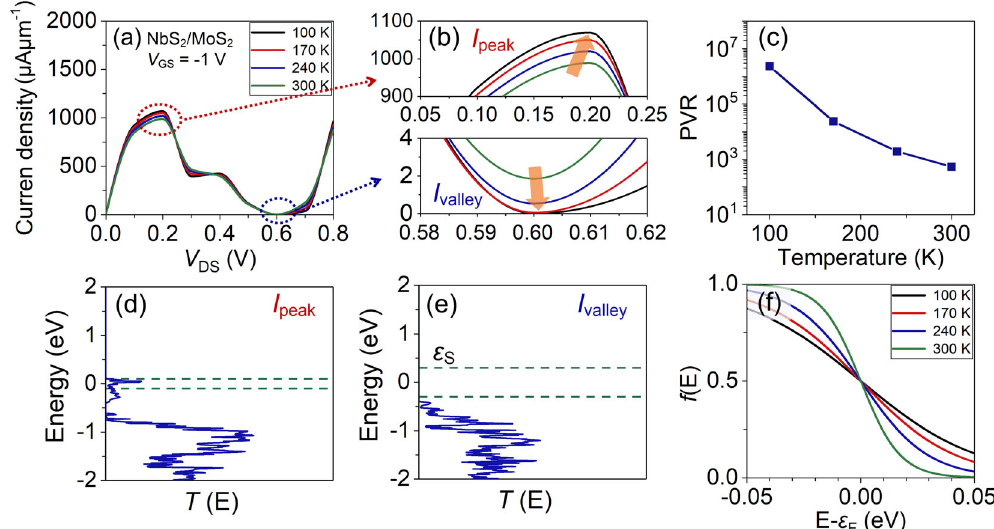
Fig. 6 The temperature characteristic of NbS 2 /MoS 2 CM-FET. a I-V curves of the NbS 2 /MoS 2 CM-FET at various temperature from 100 K to 300 K. b Enlarged views of I-V curves at peak point and valley point under different temperature. I peak and I valley represent the peak current and the valley current. c The PVR as a function of temperature from 100 K to 300 K. d, e The transmission spectrum of NbS 2 /MoS 2 MOSFET at peak point and valley point, respectively. The ε S and ε D are the Fermi level of NbS 2 and MoS 2 , respectively. The magnitude of T (E) indicates the transmission ef fi ciency of carriers. f Fermi-Dirac distribution at different